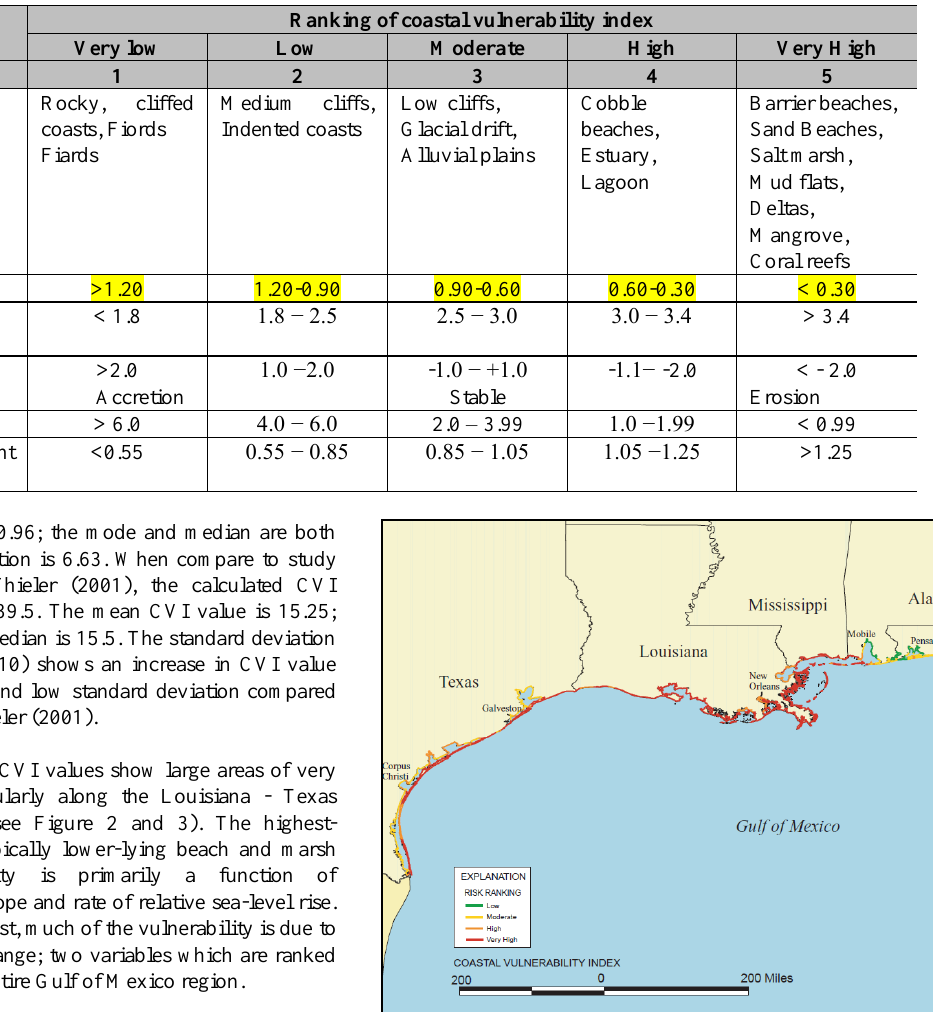
nested approach to index development and reinforcing the importance of scale in determining policy response to